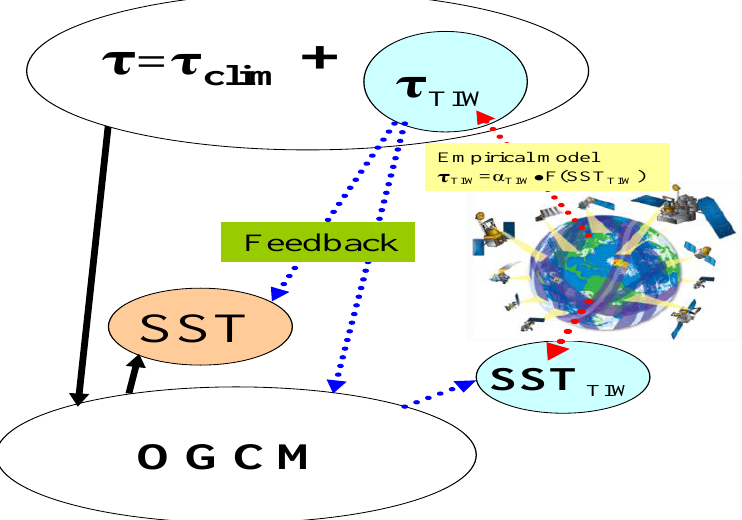
Figure 1. A schematic diagram showing the use of satellite data to represent Tropical Instability Waves (TIW)-induced surface wind feedback in a basin-scale ocean general circulation model (OGCM) of the tropical Pacific. The OGCM is forced by a prescribed climatological wind stress (τ ) field and TIW-scale surface wind stress field (τ ) over the clim TIW central-eastern tropical Pacific, with the latter (τ ) being derived using an empirical model TIW constructed from satellite observations, written as τ = α ·F(SST ). Then, given a TIW TIW TIW TIW-scale SST perturbation (SST ) from the OGCM, τ is determined accordingly. The TIW TIW derived τ part can be taken into account or not for ocean modeling, allowing isolation of TIW its feedback effect on the ocean in a clean